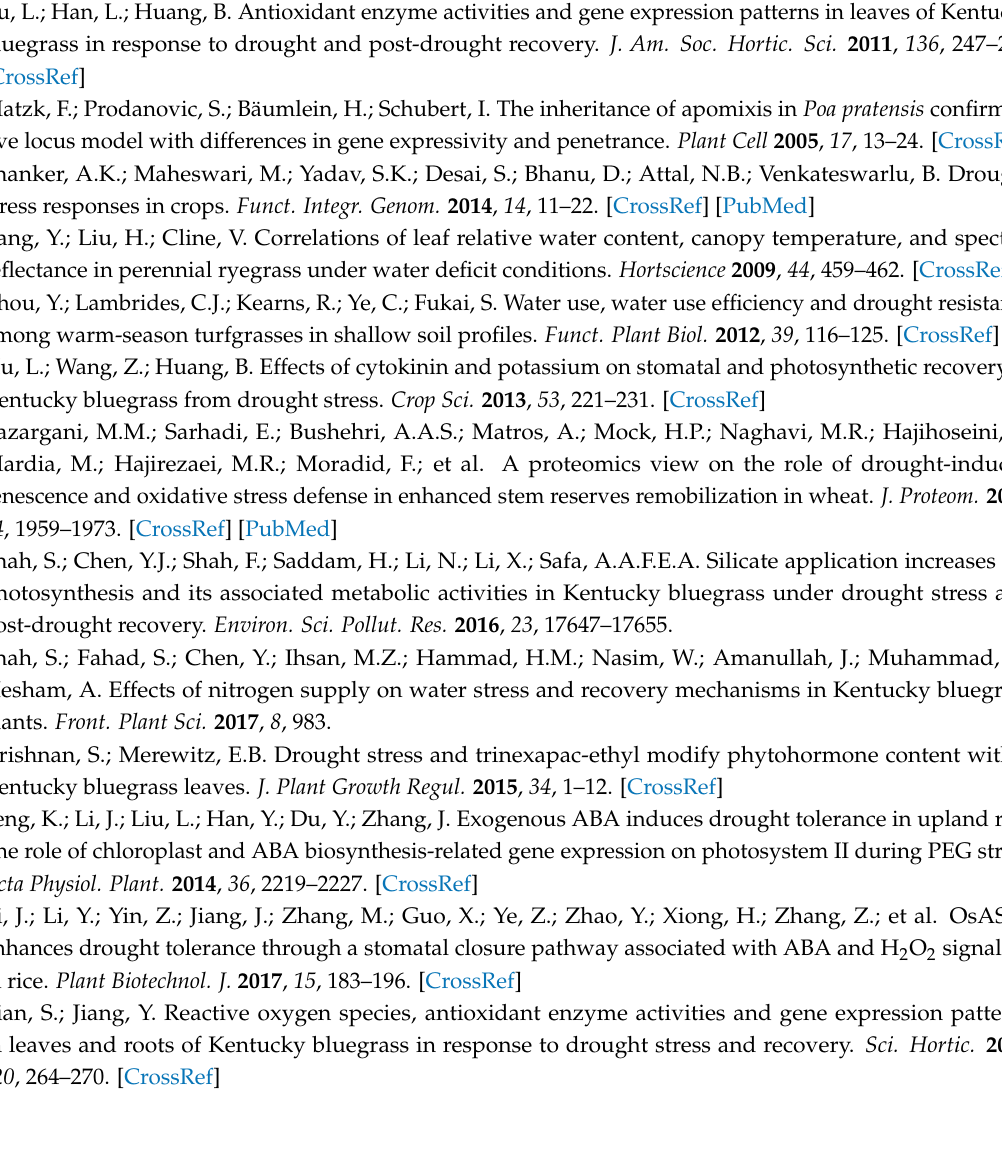
expressed genes (DEGs) in Kentucky Bluegrass under drought stress. Table S5. The primers used for qRT-PCR. Figure S1. Species distribution of all the unigene sequences. Figure S2. The repeatability of the libraries was evaluated. Figure S3. Cluster analysis of samples. Figure S4. Comparative analysis of differentially expressed genes (DEGs) in the drought